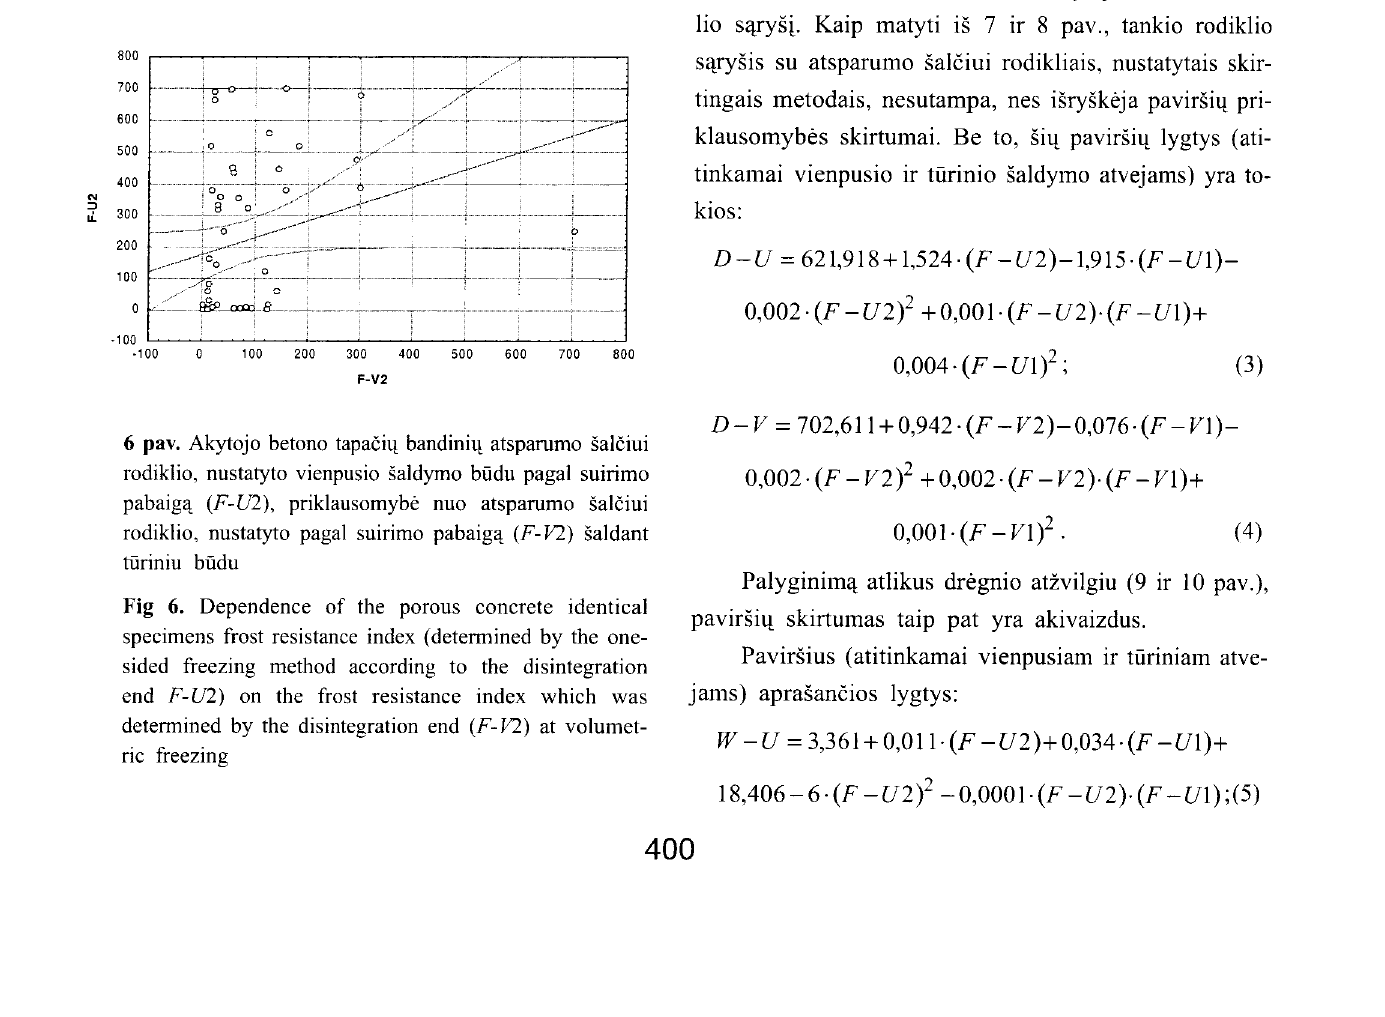
Fig 5. Dependence of the porous concrete identical specimens frost resistance index (determined by the one sided freezing method according to the disintegration start F-UI) on the frost resistance index which was de termined according to the disintegration start (F- VI) at volumetric freezing